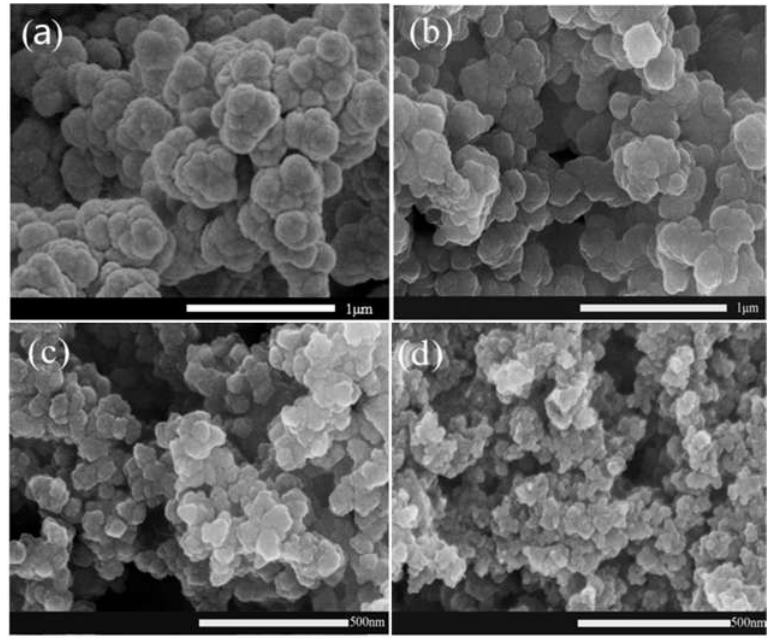
Figure 4. SEM images of WPPy doped with LGS, PPy ( a ), PPy/A1 ( b ), PPy/A4 ( c ), PPy/A6 ( d ).